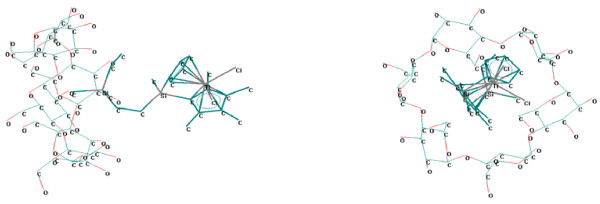
Titanocene (code 03TC) / α-cyclodextrin supramolecular system (theoretically modeled by MM+).